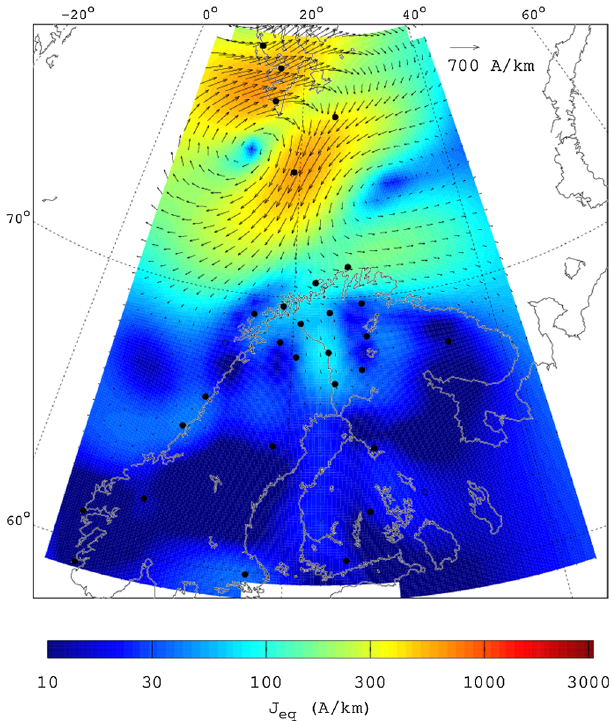
Fig. 4. The 2D spatial structure of TCV-associated ionospheric equivalent current vectors at 07:13 UT on 26 January 2012, reconstructed from the IMAGE magnetometers using the method of spherical elementary current systems. Color coding indicates the linear density of equivalent ionospheric current [A km (cid:1) 1